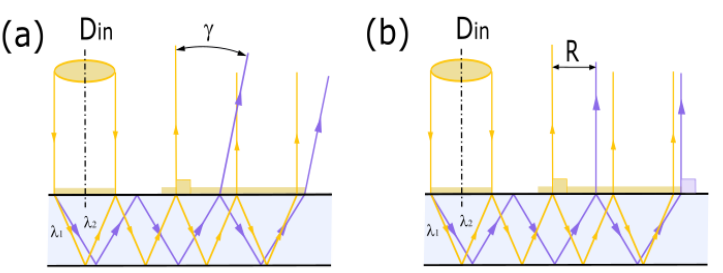
Figure 5. ( а ) The angular displacement of the beams in the absence of thermal compensation. ( b ) The displacement of the beams when the wavelength changes by ±20 nm in the scheme with thermal compensation.